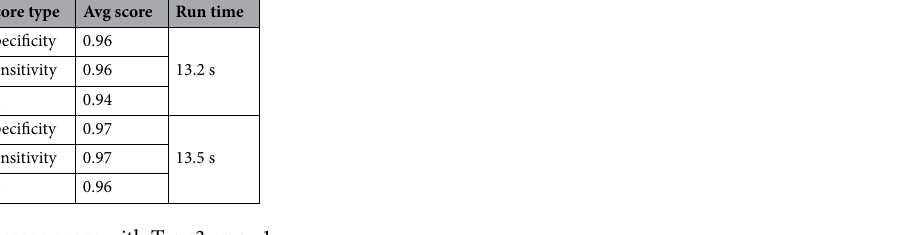
Table 7. Average score with Type3 on